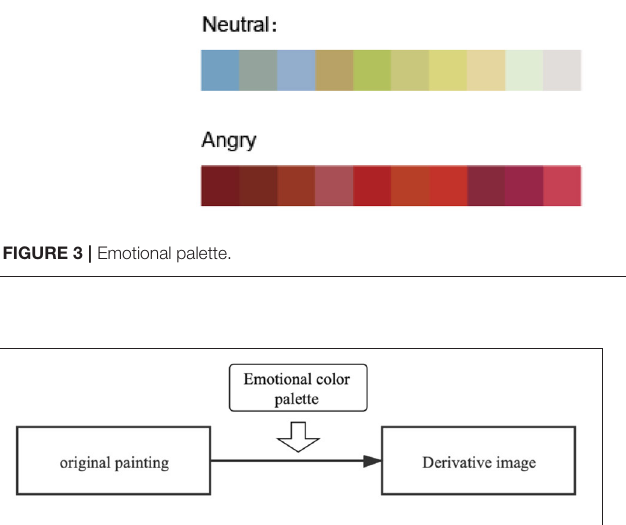
FIGURE 4 | The color replacement process.